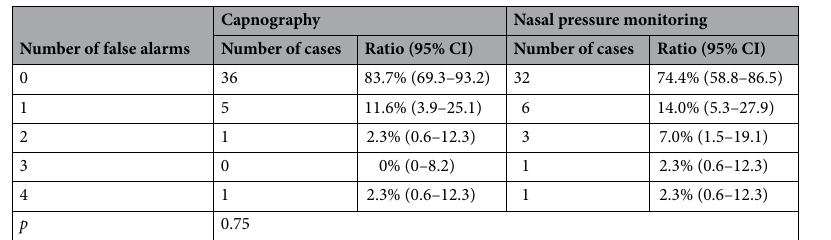
Table 4. Number of false alarms. The p -value was calculated using Fisher’s exact test. CI confidence